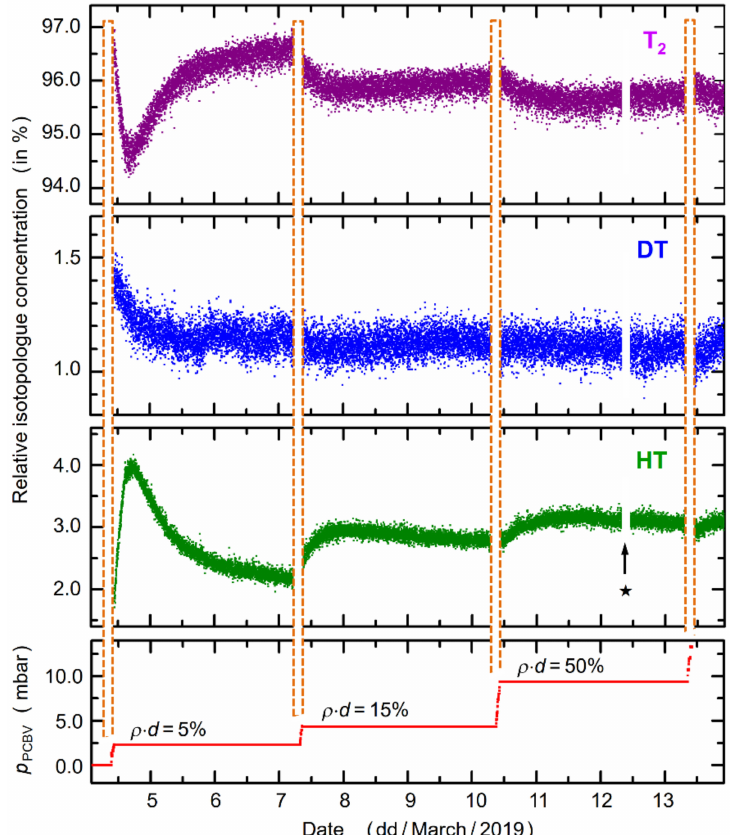
Figure 6. Temporal change of relative isotopologue concentrations of the tritium gas mixture circulating through the WGTS, during the first ramp-up to full KATRIN operation during 4–15 March 2019. Top panels: relative concentrations for the three radioactive isotopologues T 2 , DT, and HT. During the time period indicated by the symbol (cid:70) , no data were available (caused by an intermittent data transfer failure); during the ramp-up change periods (indicated by the dashed vertical lines), the system response does not tend to equilibrium—these data are excluded from the long-term analysis. Bottom panel: monitoring data for the pressure-controlled bu ff er vessel (PC-BV) during the ramp-up—the related, nominal ρ d values for the WGTS are indicated. For further details, see